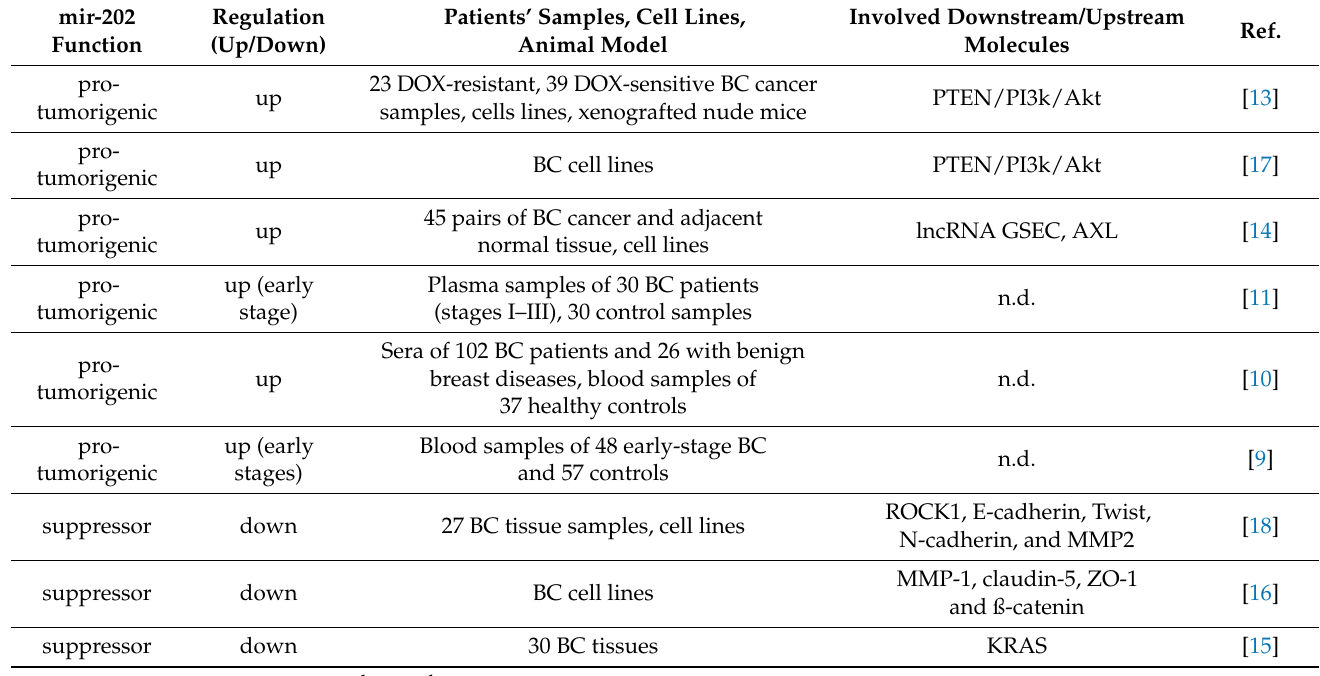
Table 1. Involvement of miR-202 in Breast Cancer progression and